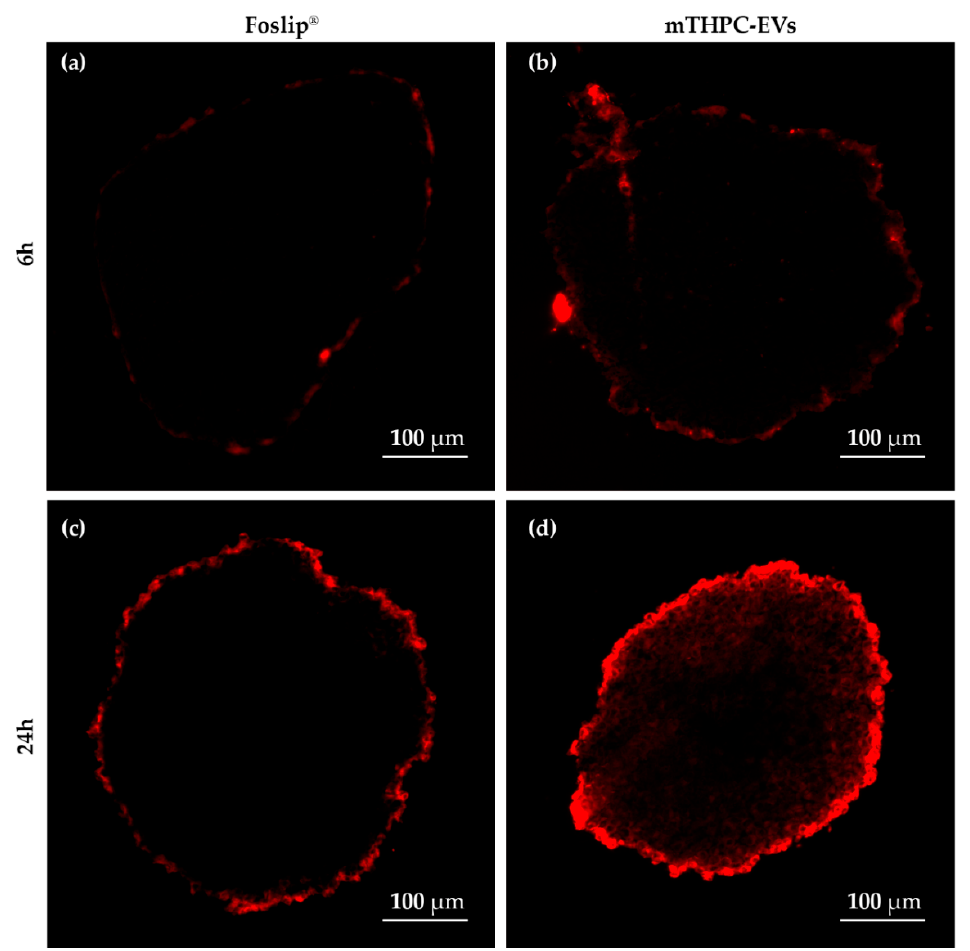
Figure 5. Fluorescence patterns of HT-29 spheroids after incubation with nanovectorized mTHPC (3.6 µM). Fluorescence images after 6 h incubation with ( a ) Foslip ® and ( c ) mTHPC-EVs and after 24 h of incubation with ( b ) Foslip ® and ( d ) mTHPC-EVs.